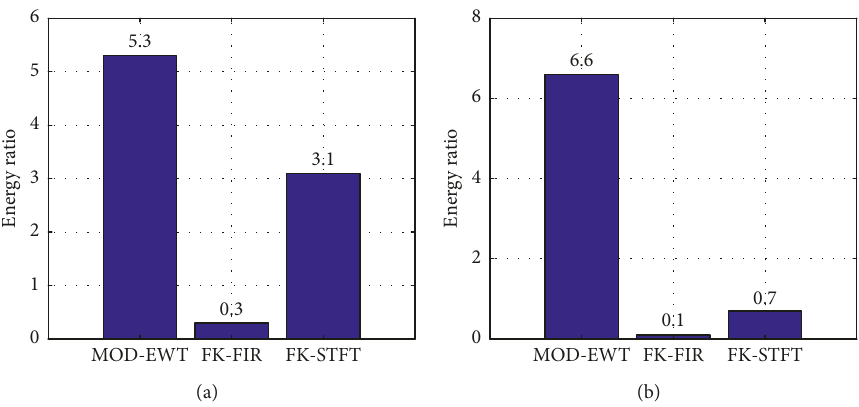
Figure 13: (a) Energy ratio histogram of case 1 by three methods; (b) energy ratio histogram of case 2 by three methods.